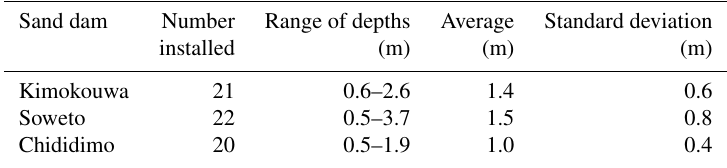
Table 3. Water table monitoring well installations at the three sand dams. Sand dam Number Range of depths Average Standard deviation installed